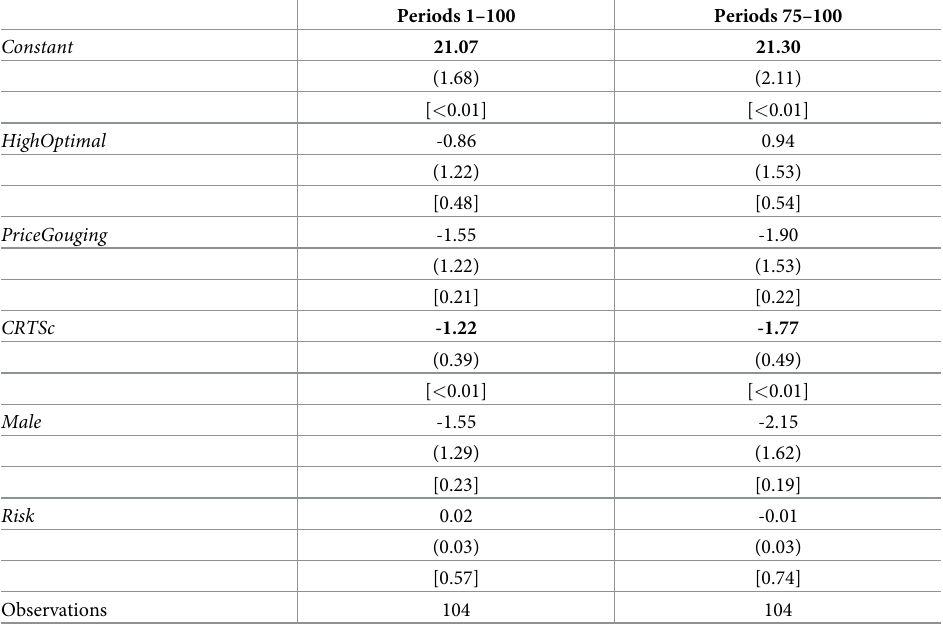
Table 6. Analysis of the within subject variation of